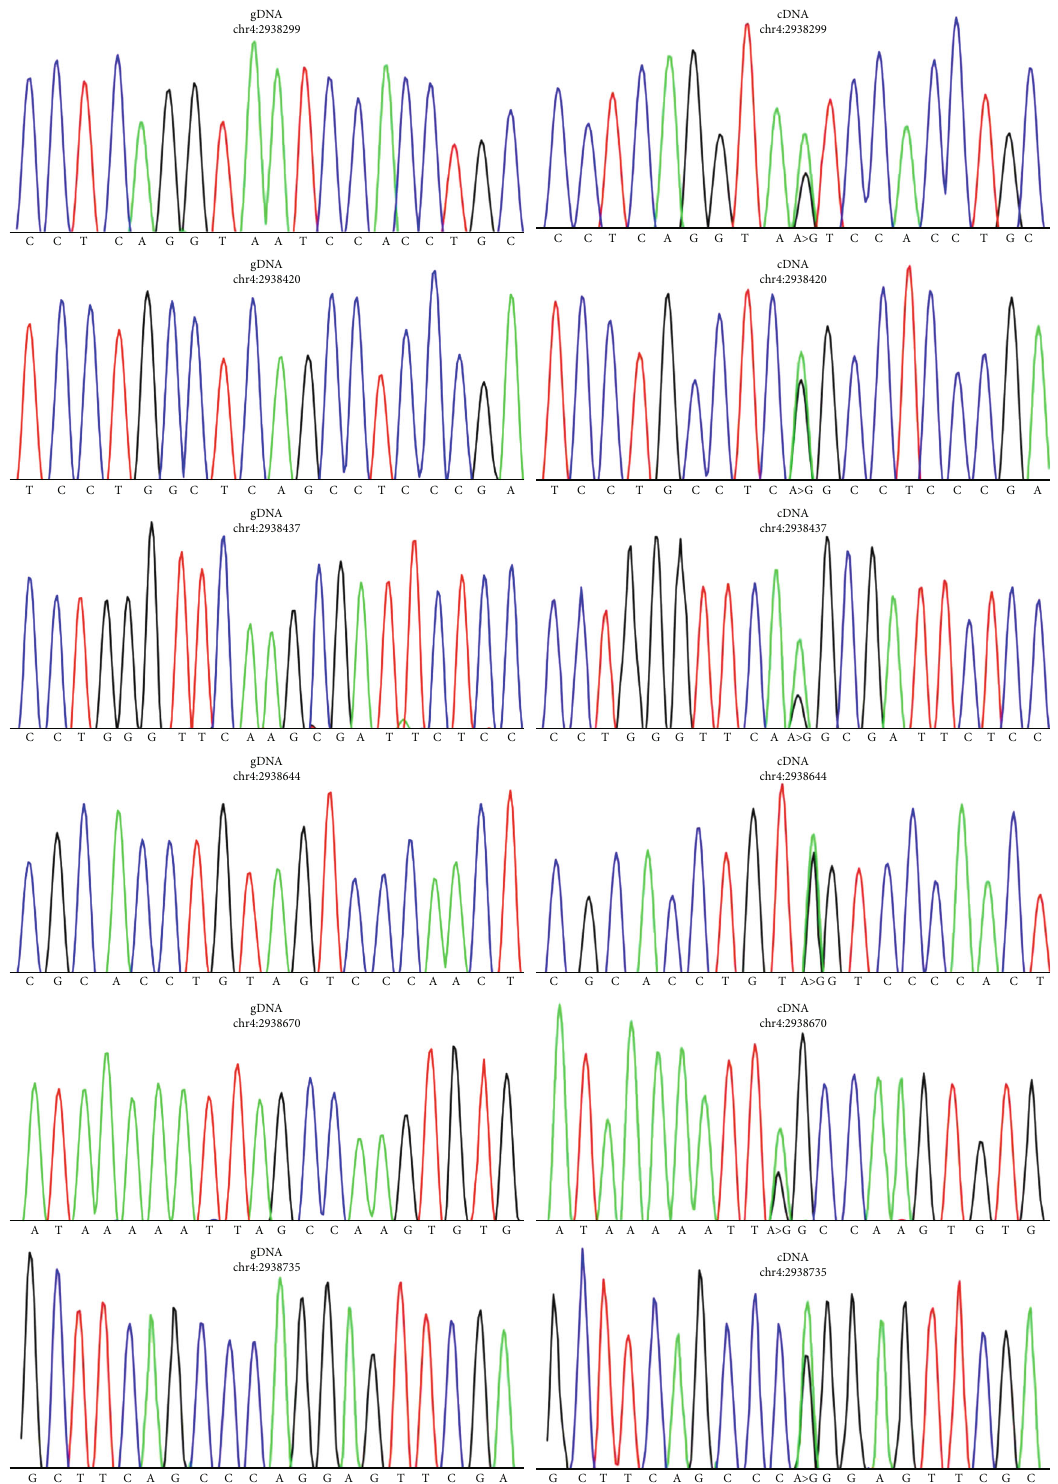
Figure 6: Chromatograms of the sequences of gDNA and cDNA at six editing loci of